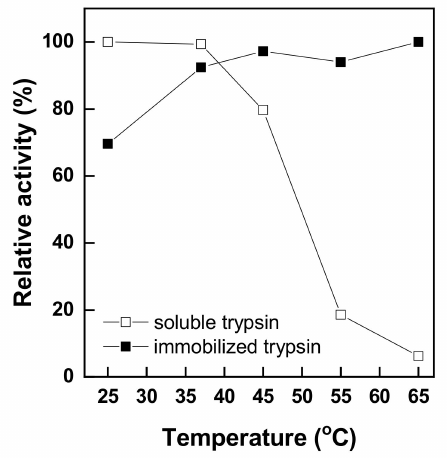
Figure 7. Thermal stabilities of soluble and immobilized